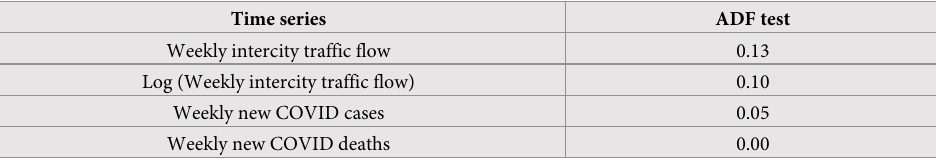
Table 1. P-values of statistical tests for